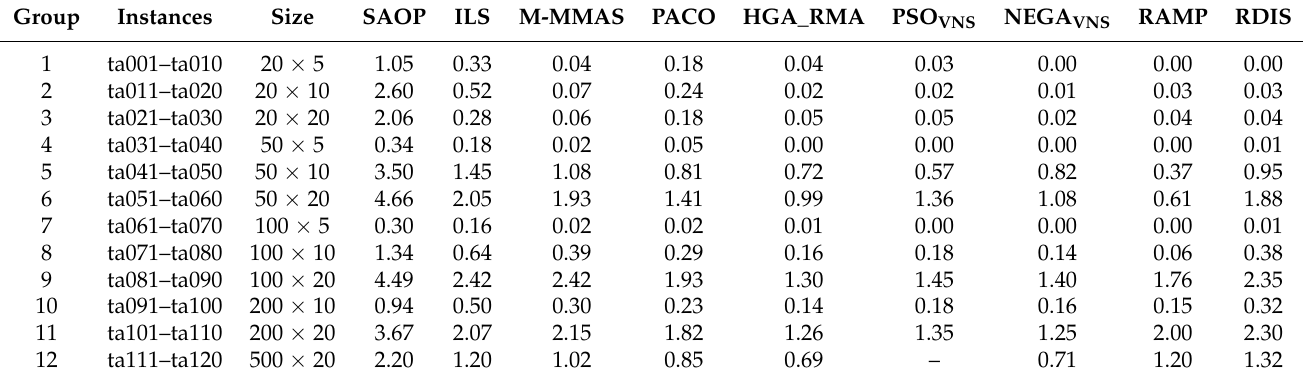
Table 1. Comparison of average percent deviation with the best methods in the